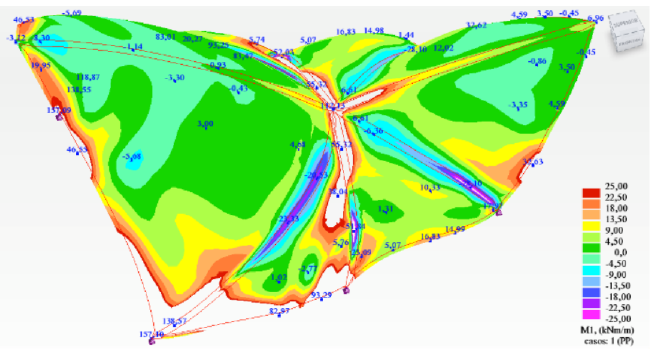
Figure 15. Bending moments according to the principal directions (M1) under self-weight load.